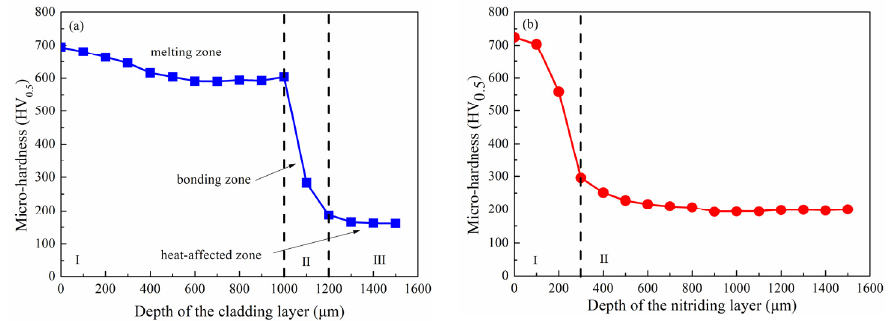
Figure 3. The section micro-hardness of: ( a ) cladding layer and ( b ) nitriding